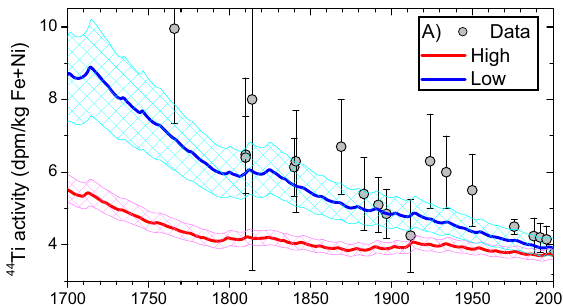
Fig.19 Timeprofileofthe 44 Tiactivitymeasured( greydots with errorbars )inthemeteoritesfallenduring the last 250 years (Taricco et al. 2006). The red and blue colored curves with the 1 σ model uncertainties (hatched areas) depict the modelled 44 Ti activity computed for “high” (e.g., Svalgaard and Schatten 2016) and“low”(e.g.,HoytandSchatten1998;Usoskinetal.2016b)reconstructionsofsolaractivity,respectively. Modified after Asvestari et al.